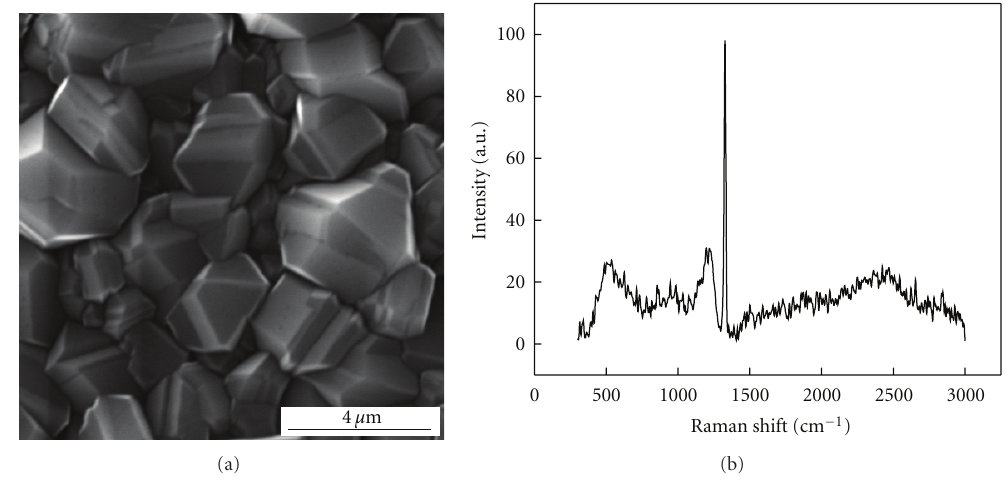
Figure 1: (a) SEM image and (b) Raman spectrum of the BDD film.